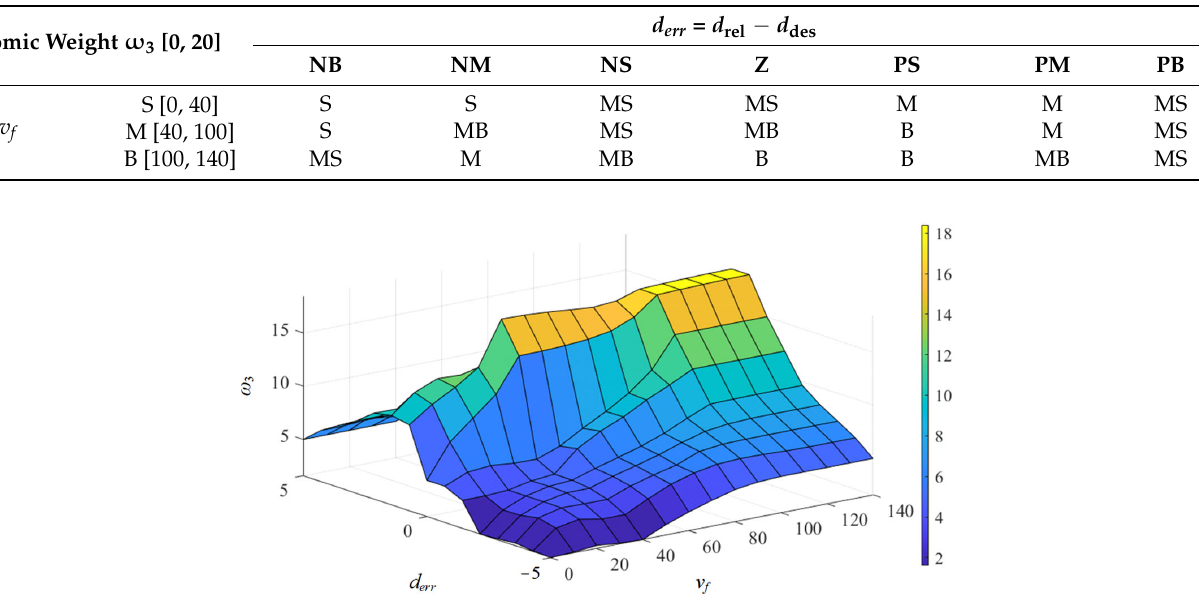
Figure 8. Relationship between distance error, v f and the economic weight coe ffi cient.